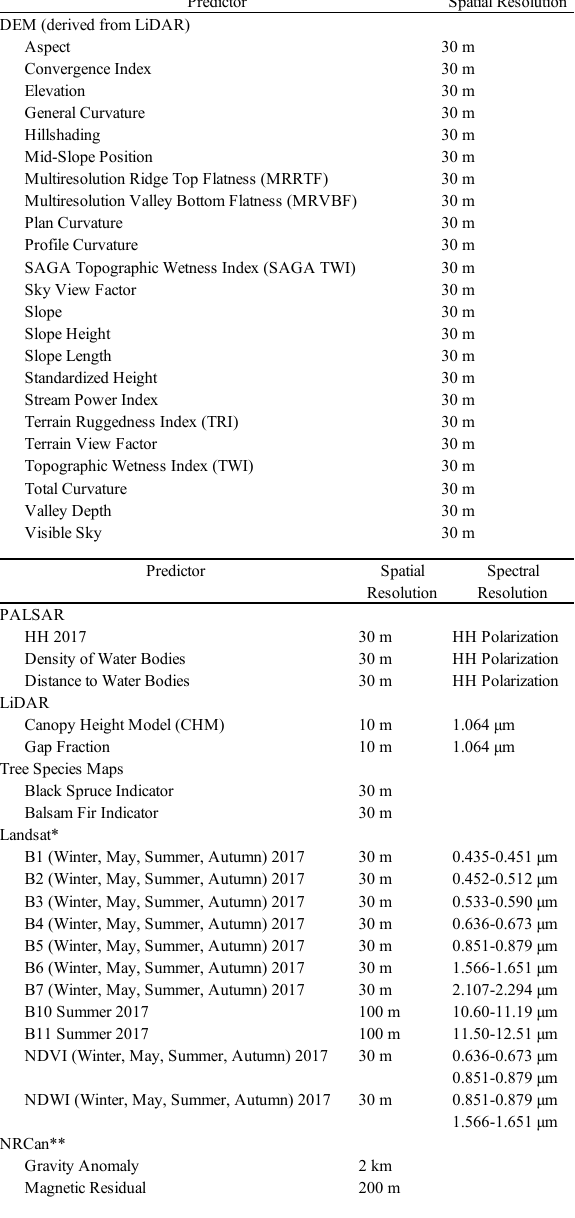
Table 1 . Listing of environmental covariates utilized as predictors for the models.